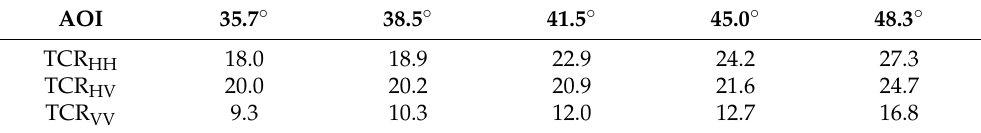
Table 4. Mean TCR values (in dB) estimated for the multi-polarisation NRCSs at the five AOIs.